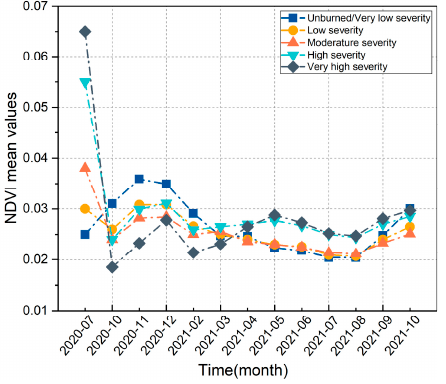
Figure 14. NDVI under different burn severities.